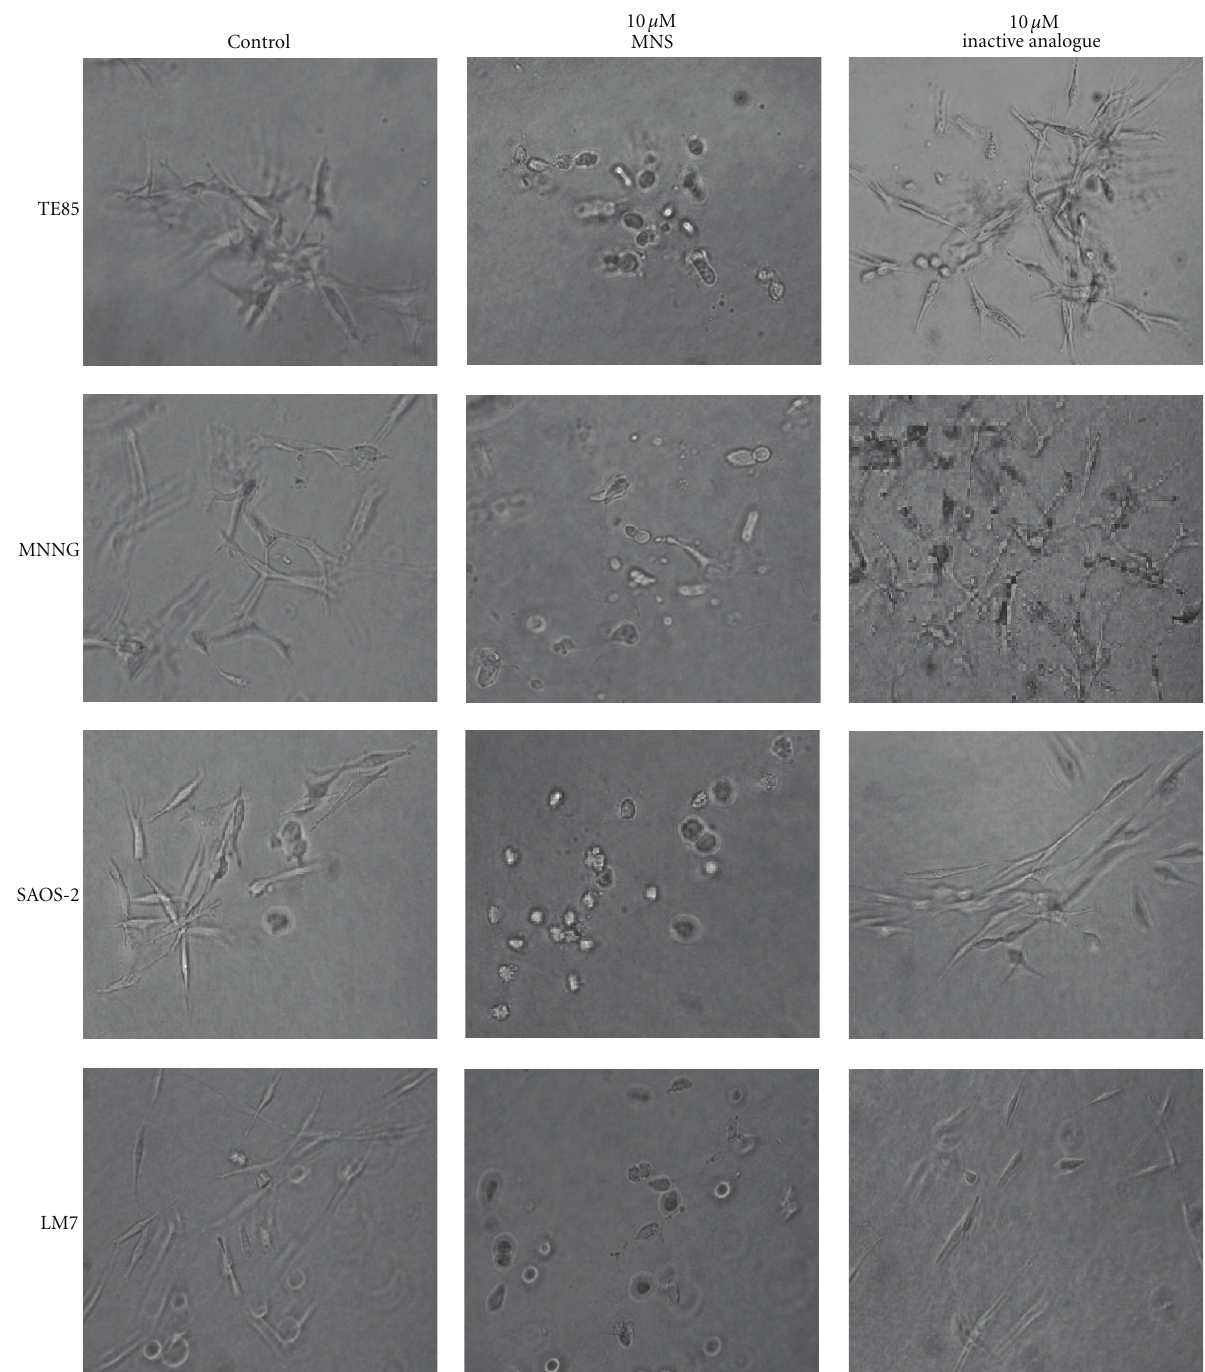
Figure 5: MNS disrupts preformed colonies of the osteosarcoma cell lines. Representative photomicrographs for each cell line 24 hours after incubation in the presence of 10 μ M MNS, 10 μ M of the inactive analogue, or 1% DMSO as a vehicle control. Each experiment was performed in triplicate, each with three wells per